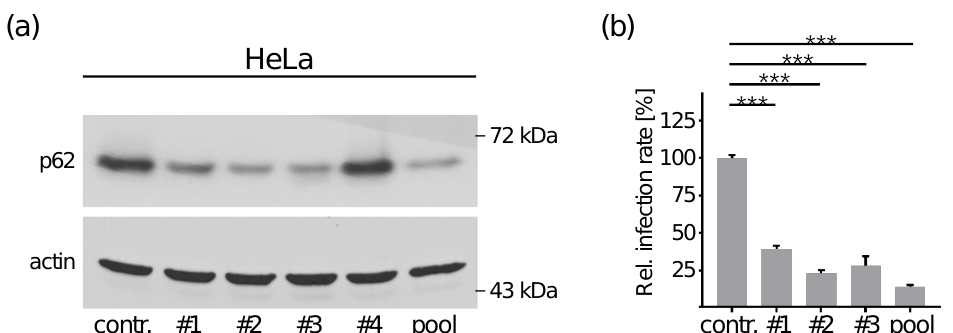
Figure 3. P62 is required for HPV16 PsV infection. ( a ) HeLa cells were transfected with control (contr.), p62-specific siRNAs (#1, #2, #3, #4) or p62 siRNA pool (pool) of all four siRNAs for 48 h. Knockdown efficiency was analyzed by Western blotting 48 h after siRNA transfection using p62-specific mAb. β -actin was used as loading control. ( b ) HeLa cells were transfected with p62-specific siRNAs for 48 h and infected with HPV16 PsVs for 24 h. Relative infection rate was assessed by luciferase activity and normalized to lactate dehydrogenase (LDH) activity as cell viability control. Infection rate is given as mean ± SEM, and the mean for control siRNA-treated cells was set to 100%. Data ( n = 7 out of three replicates) were analyzed for significance using the one-way ANOVA test; p < 0.0001 (***).